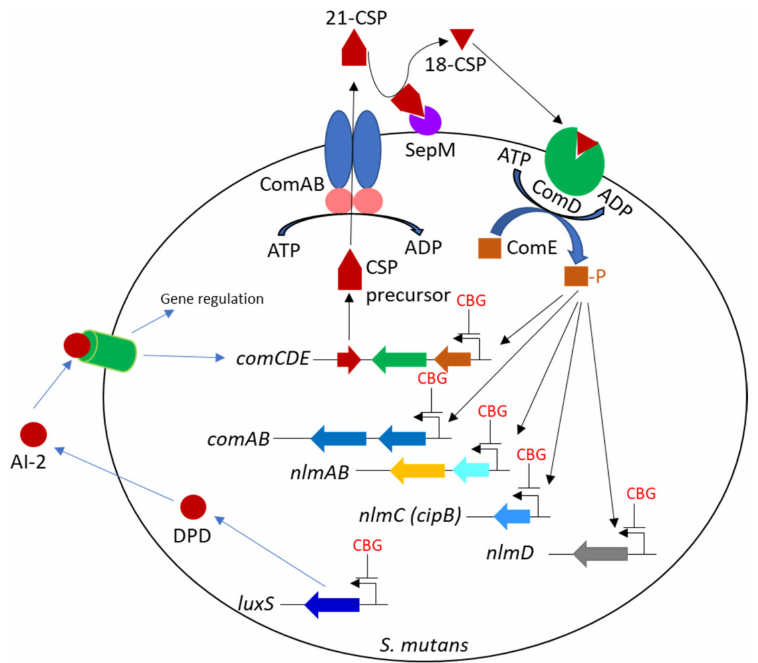
Figure 11. The anti-QS activity of CBG on S. mutans . CBG prevents the transcription of the comC , comD , comE , comA , nlmA , nlmB , nlmC and luxS genes, thus preventing the CSP and AI-2-induced QS signal transduction